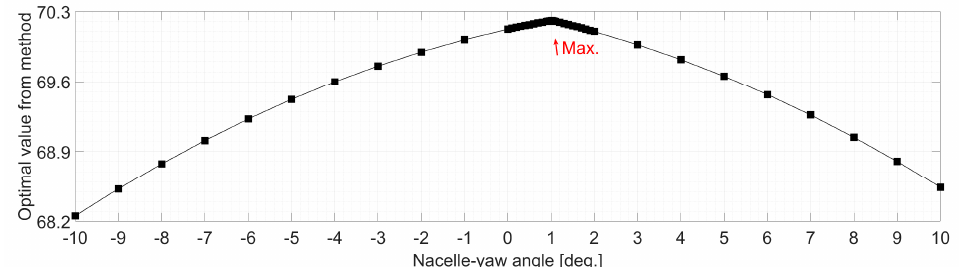
Figure 12. Optimal curve of the multiobjective optimization problem.